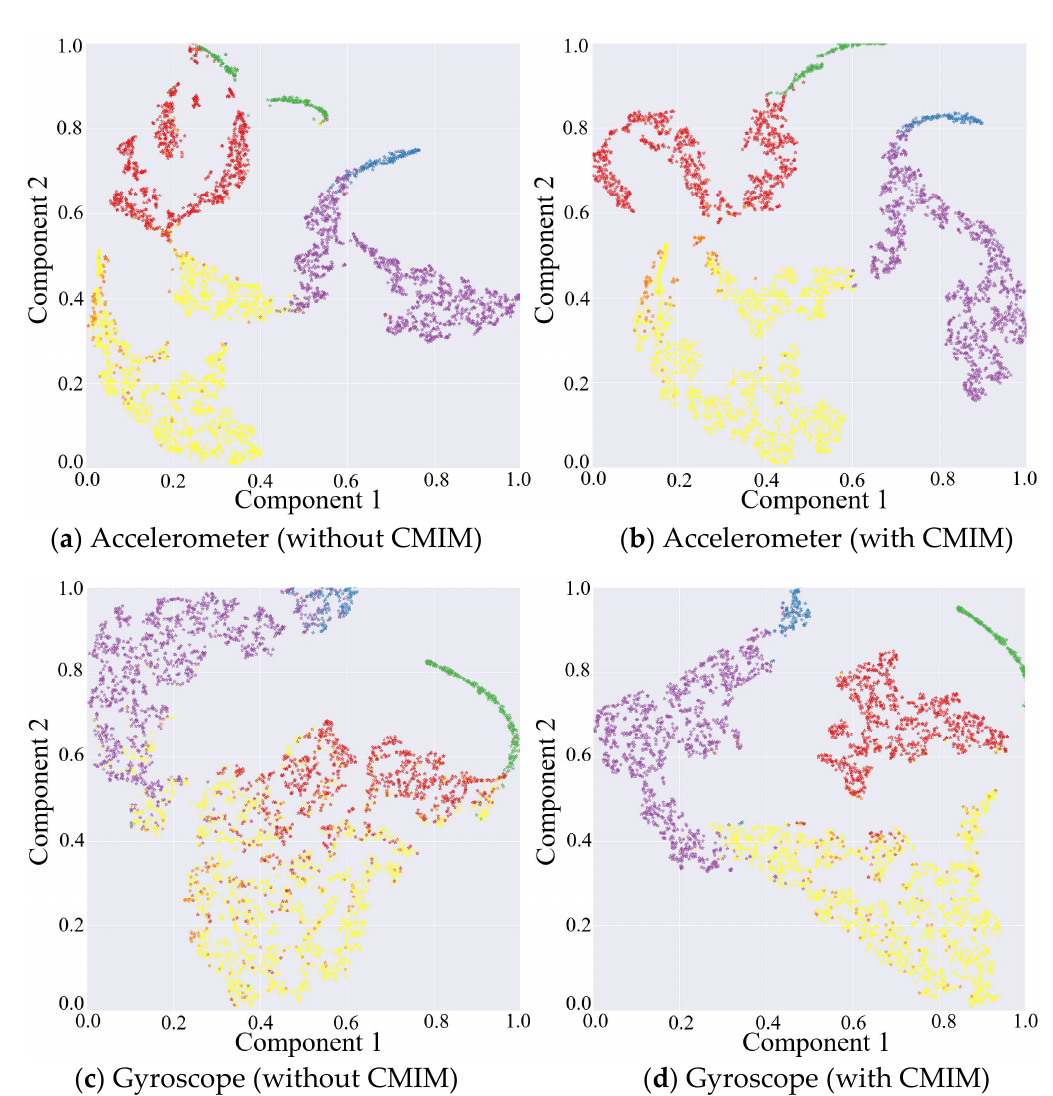
Figure 3. Embedding visualization of the features extracted from triaxial accelerometer and gyroscope data under network without and with CMIM, respectively.